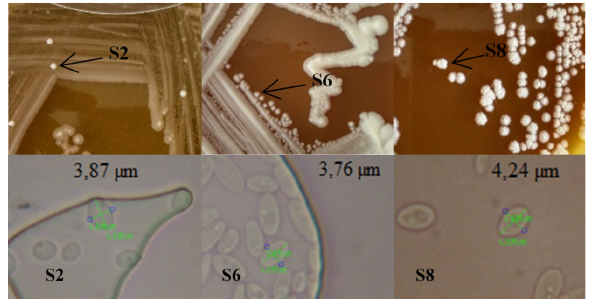
Figure 1 Macroscopic and microscopic images of selected indigenous yeast